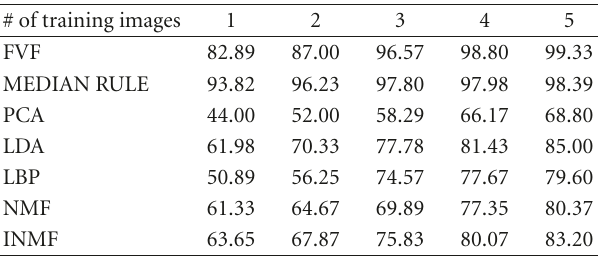
Table 6: Performance of the proposed face recognition system using FVF, Median Rule, PCA, LDA, LBP, NMF, and INMF based face recognition system for the FERET face